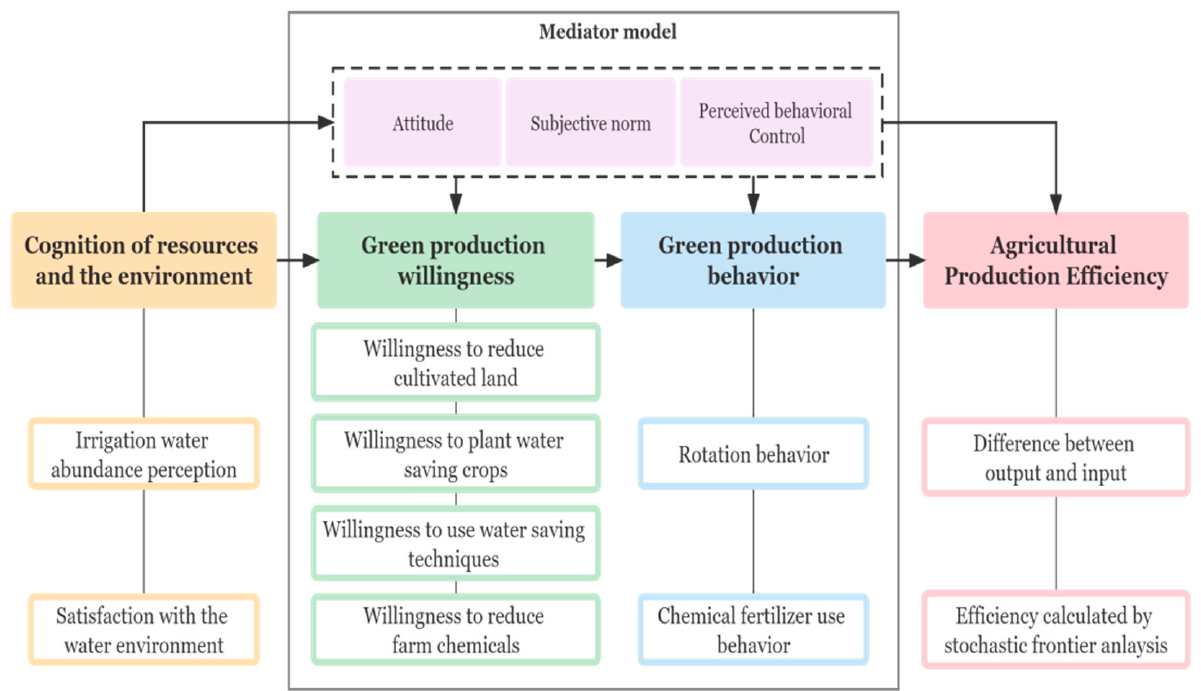
Figure 1. Research framework based on the theory of planned behavior.